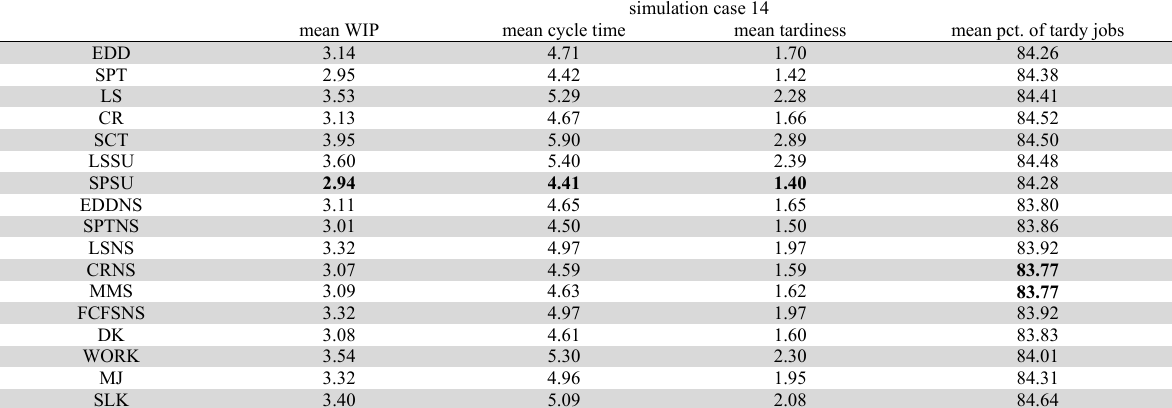
Results for simulation case 14. The minimum values for each performance metric and simulation case are denoted in